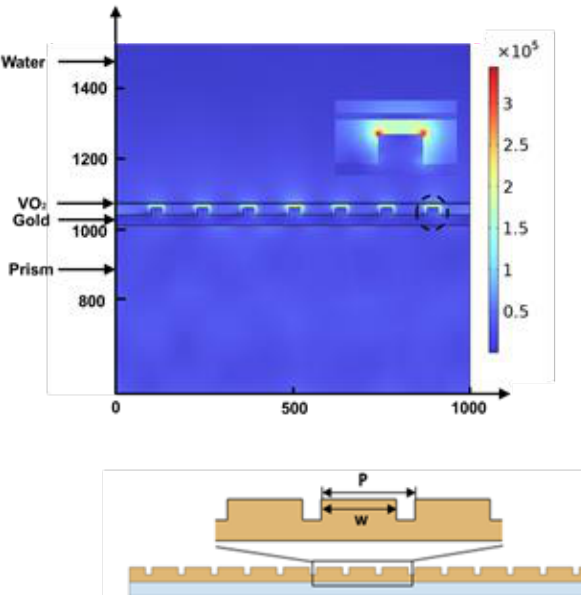
Figure 6. Electric field (norm in V/m) distribution inside the structure, given that the thickness of the continuous gold film, metasurface, and VO 2 are 30, 20, and 4 nm, respectively, for excitation 630 nm, temperature 95 ° C, periodicity 130 nm, and width 30 nm.